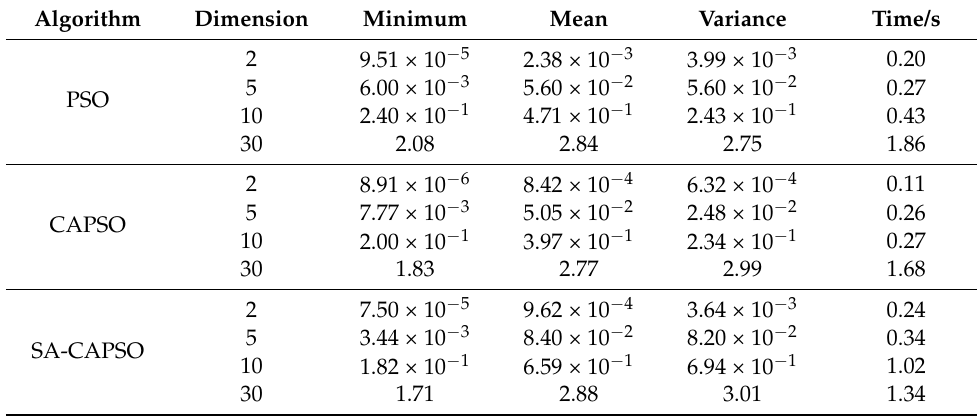
Table 7. The solution result of the test function